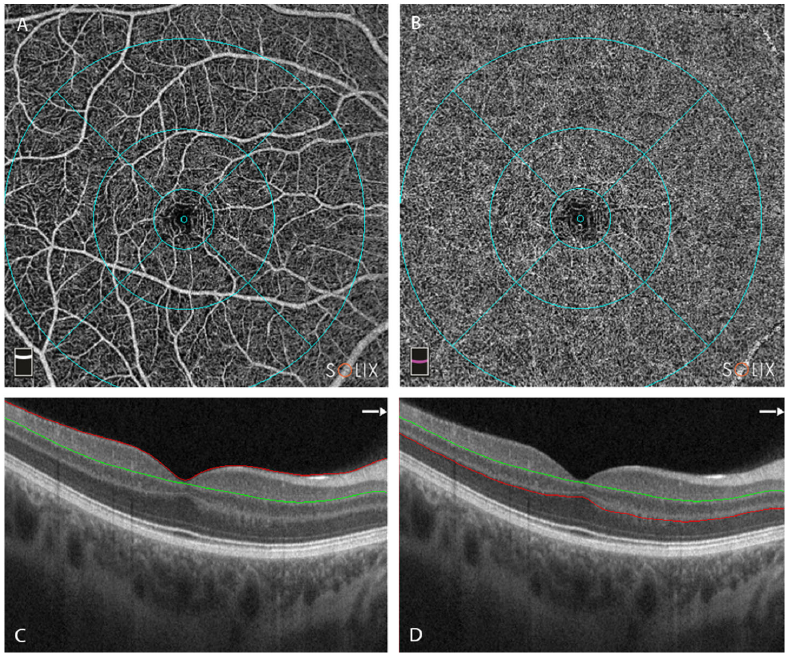
Figure 3. Overview of the optical coherence tomography angiography (OCTA) centered on the fovea. Retinal layer segmentation was automatically performed using the OCTA device and manually reviewed and corrected where necessary. ( A ) En-face image of superficial capillary plexus (SCP) ( B ) En-face image of deep capillary plexus (DCP) ( C ) Cross-sectional OCT B scan centered on the fovea, with segmentation of the SCP. Red line represents upper limit of slab = ILM; green line represents lower limit = IPL − 10 µm [29]. ( D ) Cross-sectional OCT B scan centered on the fovea, with segmentation of the DCP. Green line represents upper limit of slab = IPL − 10 µm; red line represents lower limit = OPL + 10 µm; Legend : ILM, internal limiting membrane; IPL, inner plexiform layer; OPL, outer plexiform layer. Figure 4. En-face OCTA image of the combined SCP and DCP. The inner yellow circle marks the outer border of the FAZ; the outer yellow circle represents 300 µm from the FAZ border; FD-300 vessel density between the rings is calculated by the device. Legend: DCP, deep capillary plexus;